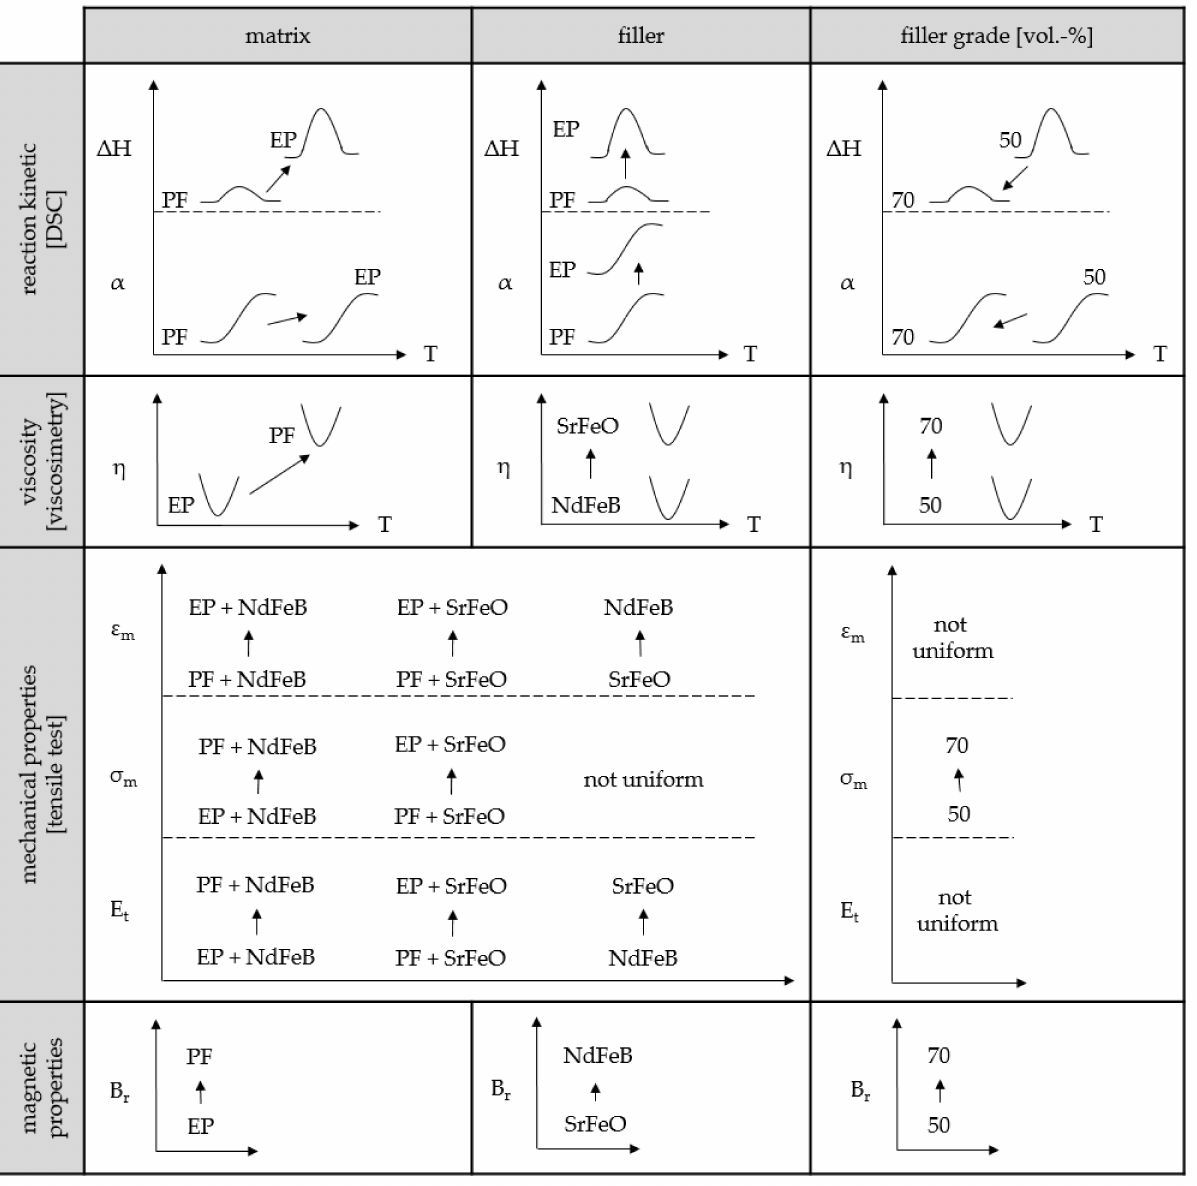
Figure 13. Overview of the impact of matrix, filler and filler grade on the reaction kinetics, the viscosity, the mechanical and magnetic properties and the correlation between the parameters (SrFeO: strontium-ferrite-oxide; NdFeB: neodymium-iron-boron; PF: phenolic resin; EP: epoxy